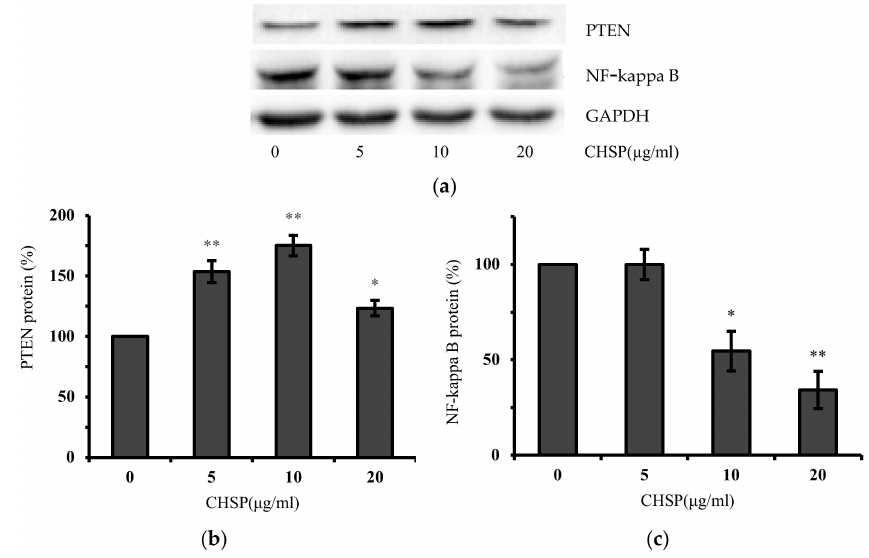
Figure 5. CHSP up-regulated the expression of PTEN and down-regulated NF-kappa B protein in OVACAR-3 cells. ( a ) CHSP increased the levels of PTEN and decreased the levels of NF-kappa B in OVCAR-3 cells. ( b ) PTEN. ( c ) NF-kappa B. * p < 0.05 as compared to control. ** p < 0.01 as compared to